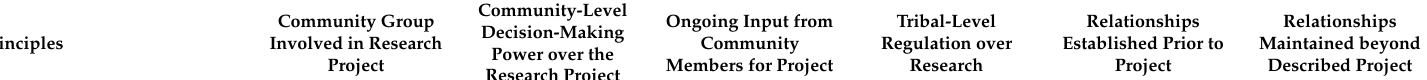
Table 1. Inclusion criteria alignment with participatory research (PR)